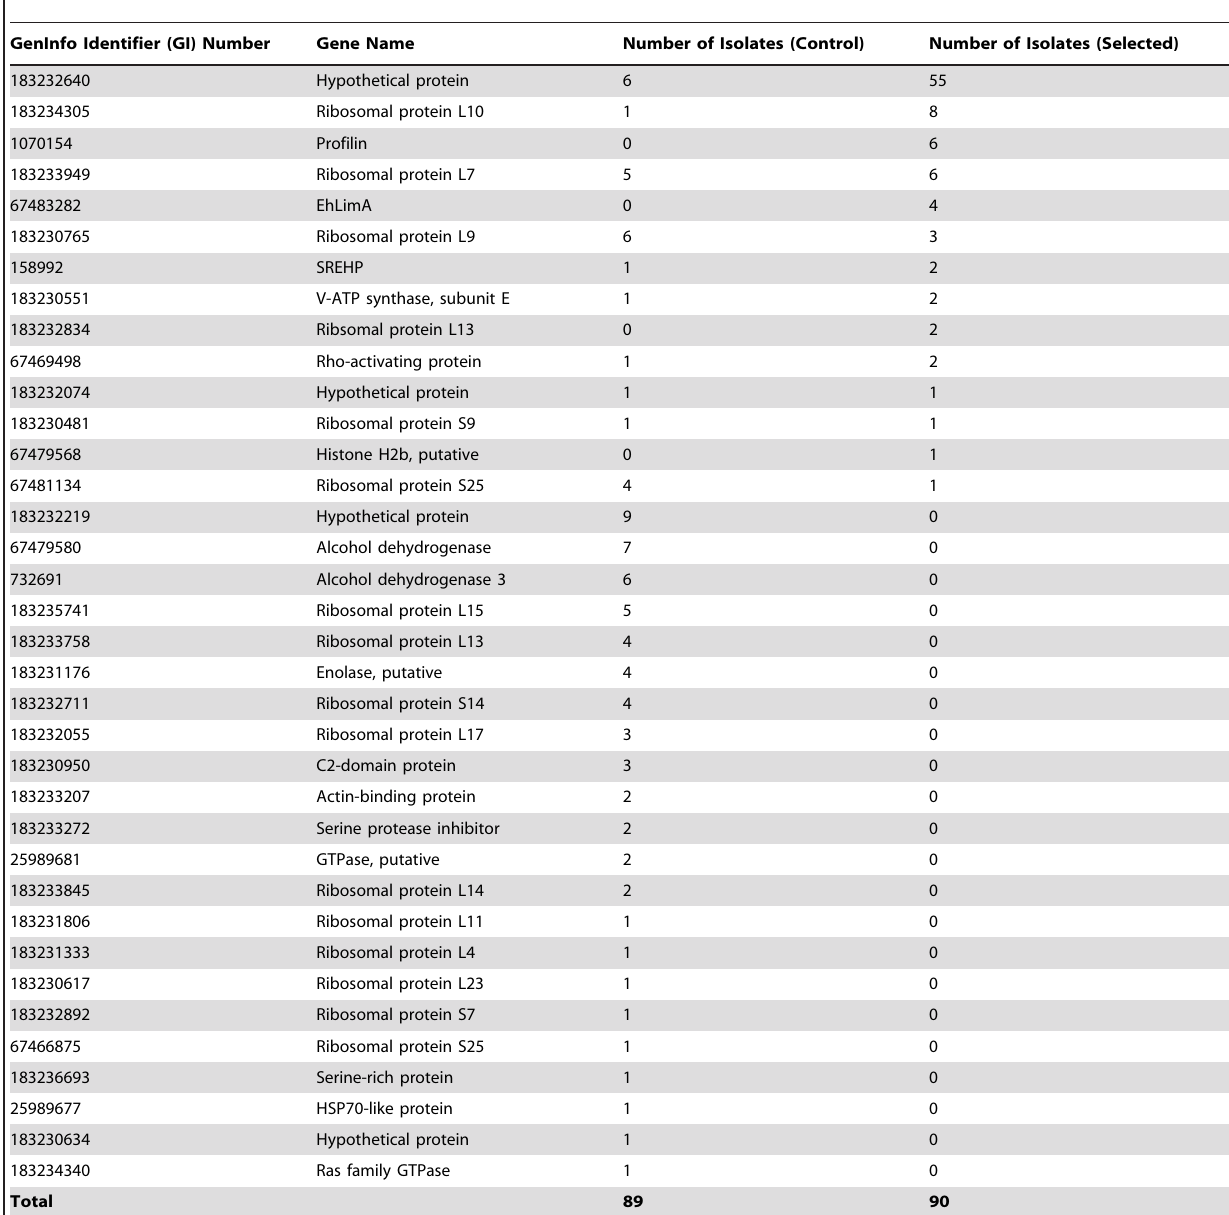
Table 1. Isolation of cDNAs from E. histolytica over-expressors without (Control) and with (Selected) selection with tubercidin- charged